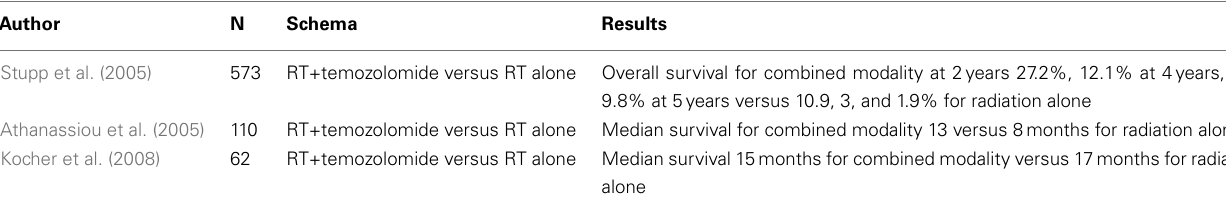
Table 3 | GBM clinical trials with